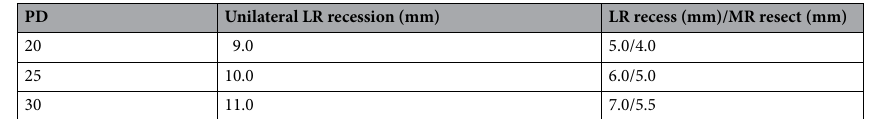
Table 1. Surgical dosage based on near exodeviation angles. PD prism diopters, LR lateral rectus, MR medial